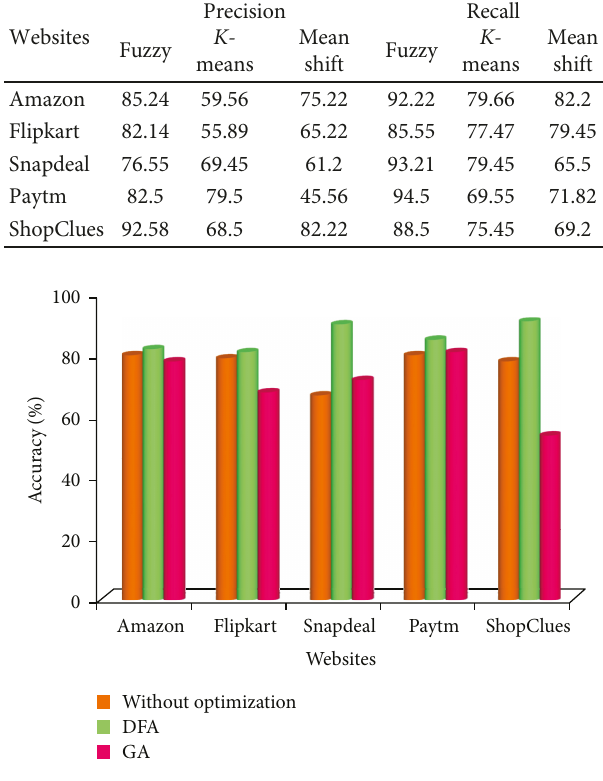
Figure 3: Optimization results.